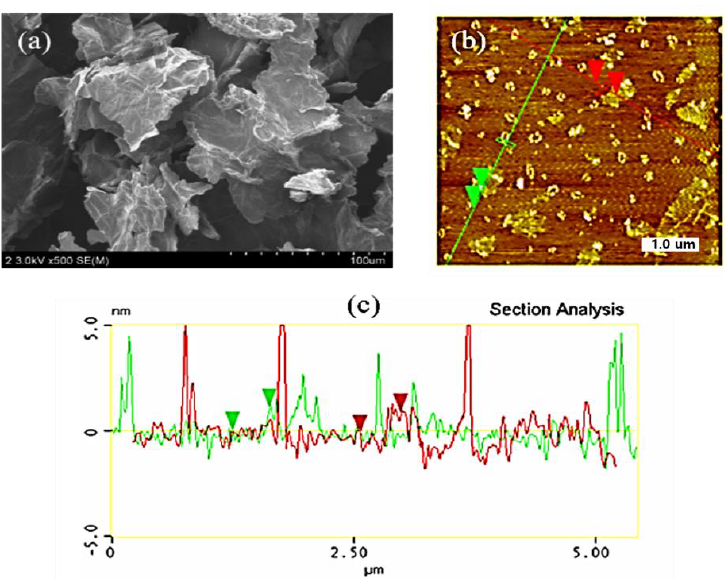
Figure 1. ( a ) field emission scanning electron microscopy (FESEM) image of graphene oxide (GO), ( b ) atomic force microscopy (AFM) image of GO, and ( c ) height profile of GO.